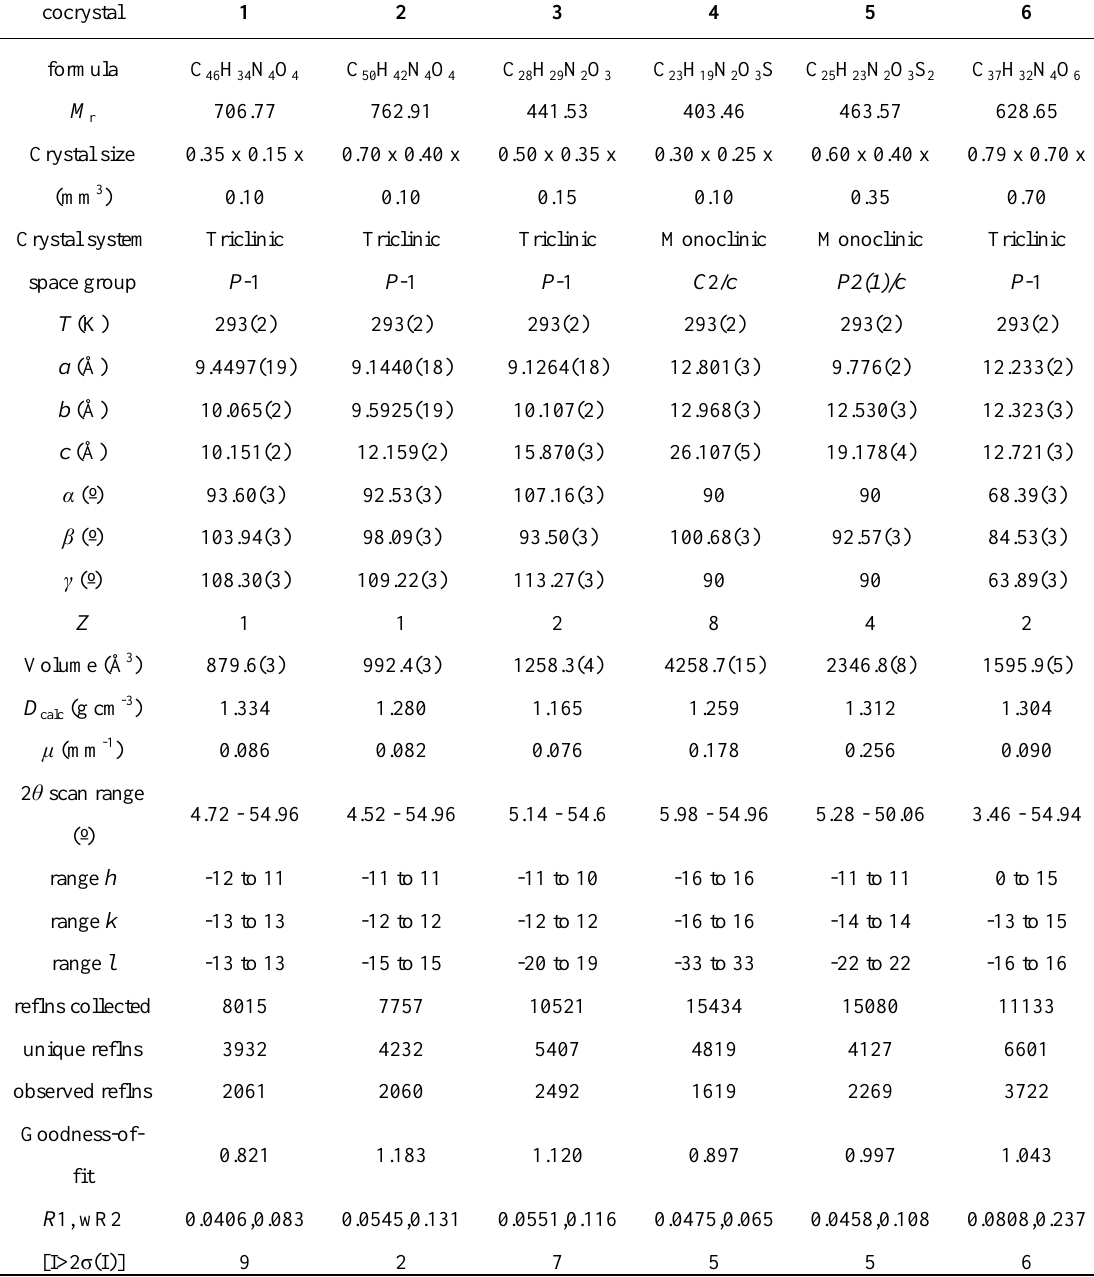
Table 1. Crystallographic Data for